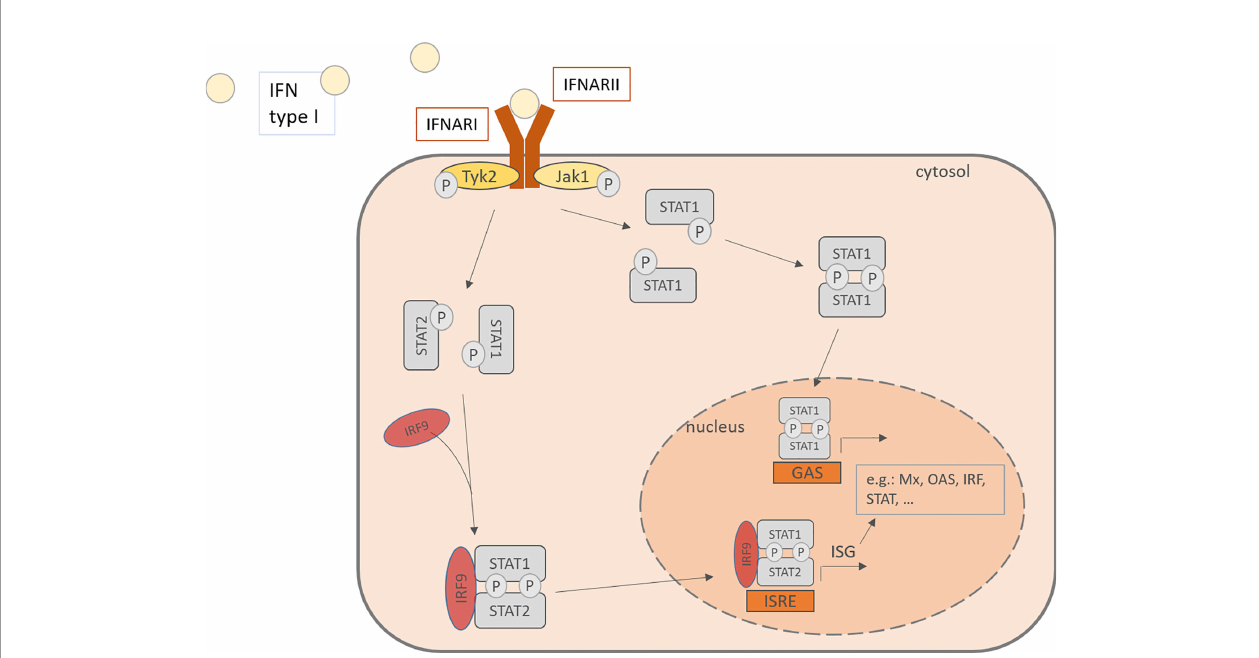
FIGURE 2 | IFN type I activates in an autocrine or paracrine manner the cells through the IFNAR, consisting of IFNARI and IFNARII. This activation of the JAK-STAT pathway leads to the phosphorylation of STAT and its translocation to the nucleus where it binds to promoters and activates the transcription of IFN stimulated genes. IFN, Interferon; IFNARI, Interferon- a / b receptor subunit I; IFNARII, Interferon- a / b receptor subunit II; Tyk2, tyrosine kinase 2; Jak1, Janus kinase 1; Stat, signal transducer and activator of transcription; IRF, Interferon regulatory factor; P, phosphorylated; ISRE, interferon-stimulated response elements; GAS, gamma activating sequences; Mx, Interferon-induced GTP-binding protein Mx1; OAS, 2 ’ -5 ’ -oligoadenylate